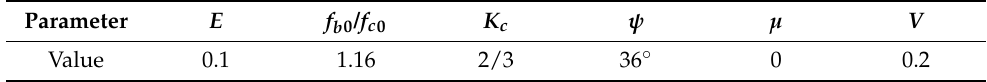
Table A1. Summary of chosen parameters for CDP